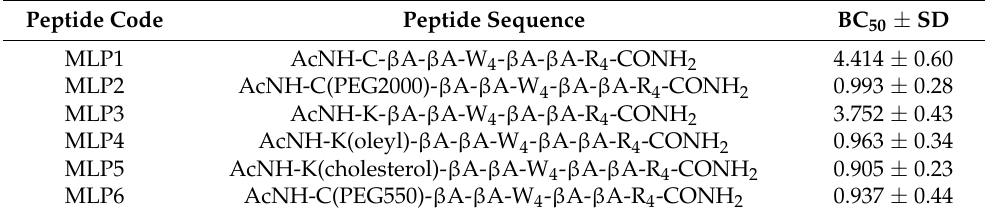
Table 2. BC 50 values of synthesized peptides.